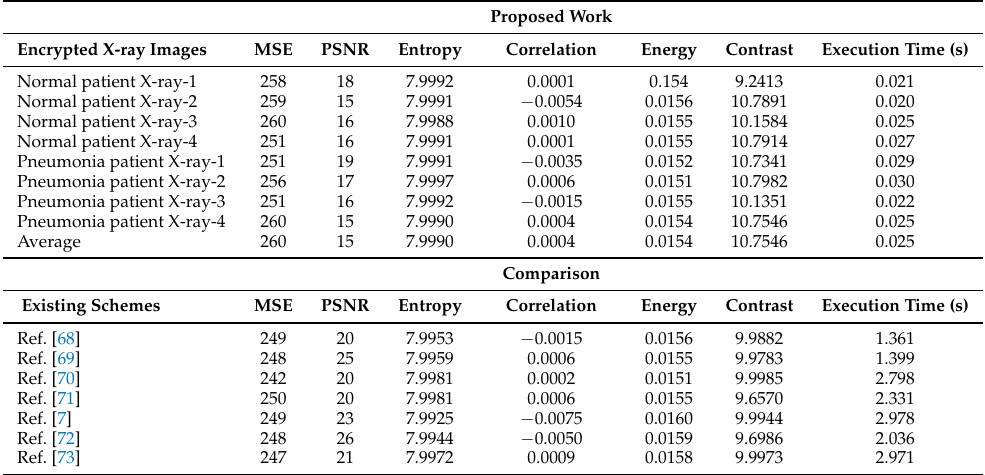
Table 1. Statistical security analysis of the proposed and existing encryption schemes.